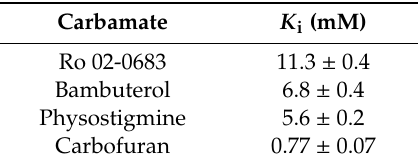
Table 5. PON1-carbamate complex binding interactions with the active site gorge residues evaluated by molecular docking. The crystal structure of PON1 used was PDB ID 1V04.